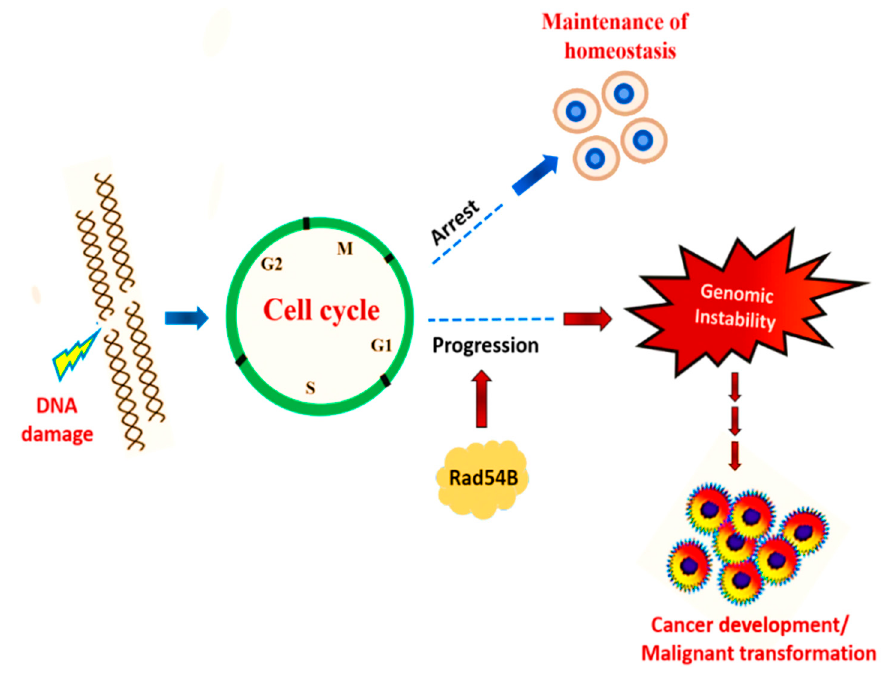
Figure 1. Cell cycle regulation in response to DNA damage.